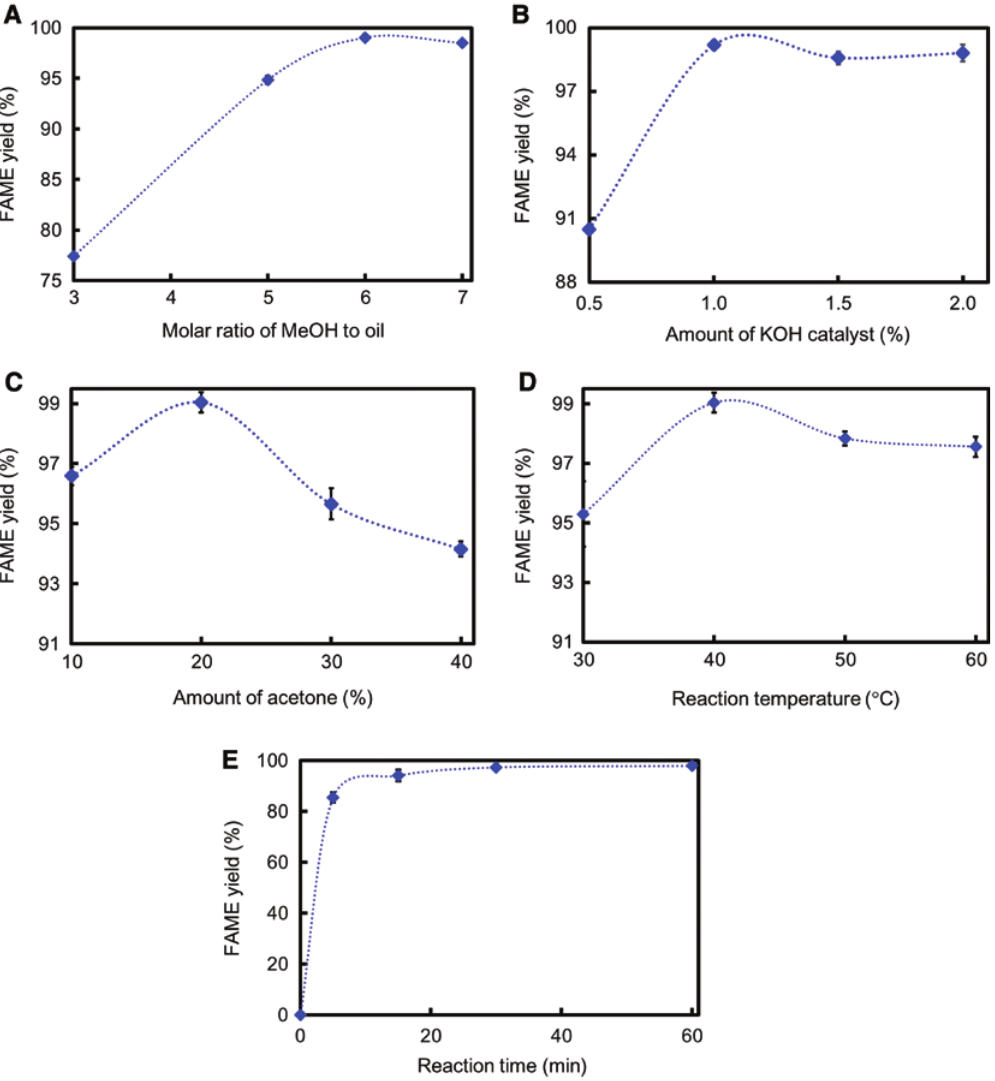
Figure 2: Effects of the (A) MeOH/oil molar ratio, (B) amount of catalyst, (C) amount of acetone, (D) reaction temperature, and (E) reaction time on the BDF conversion efficiency. Reaction conditions: (A) 20% (wt/wt) acetone, 1% (wt%) KOH at 40 ° C in 60 min; (B) 6/1 MeOH/oil molar ratio, 20% (wt/wt) acetone at 40 ° C in 60 min; (C) 6/1 MeOH/oil molar ratio, 1% (wt%) KOH at 40 ° C in 60 min; (D) 6/1 MeOH/oil molar ratio, 1% (wt%) KOH in 60 min; (E) 6/1 MeOH/oil molar ratio, 20% (wt/wt) acetone, 1% (wt%) KOH at 40 °